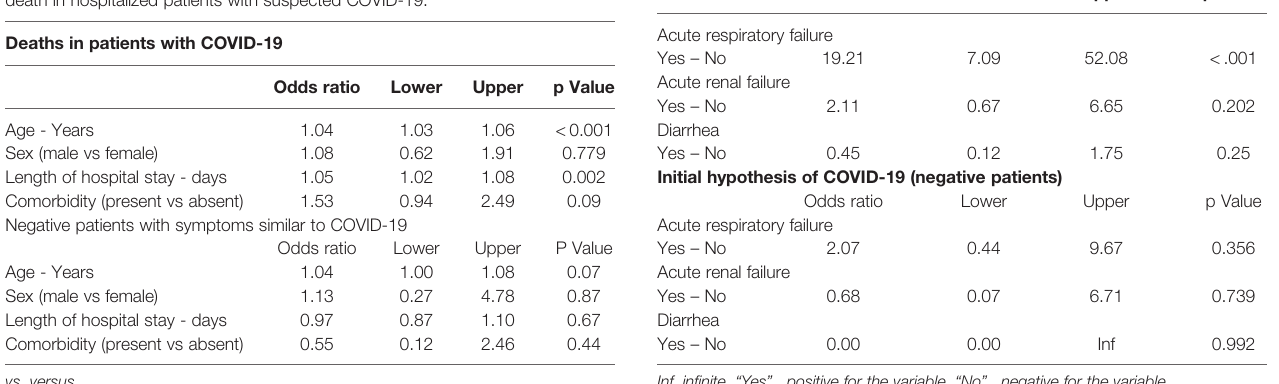
TABLE 3 | Binomial logistic regression model to verify the association of the variables age, sex, length of stay, and absence or presence of comorbidities with death in hospitalized patients with suspected COVID-19.